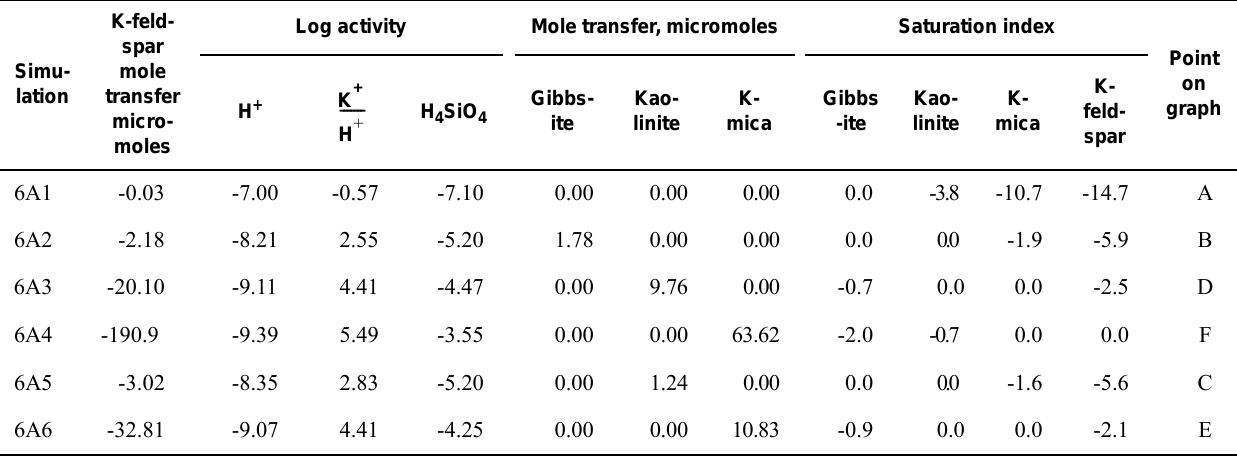
Table 22. Selected results for simulation 6A. [Simulation refers to labels in the input file for simulation 6A. Negative mole transfers indicate dissolution, positive mole transfers indicate precipitation. Simulations 6A1–6A6 refer to label points A–F on figure .7 and table .24 . H + , hydrogen ion; K + , potassium ion; H 4 SiO 4 , silicic